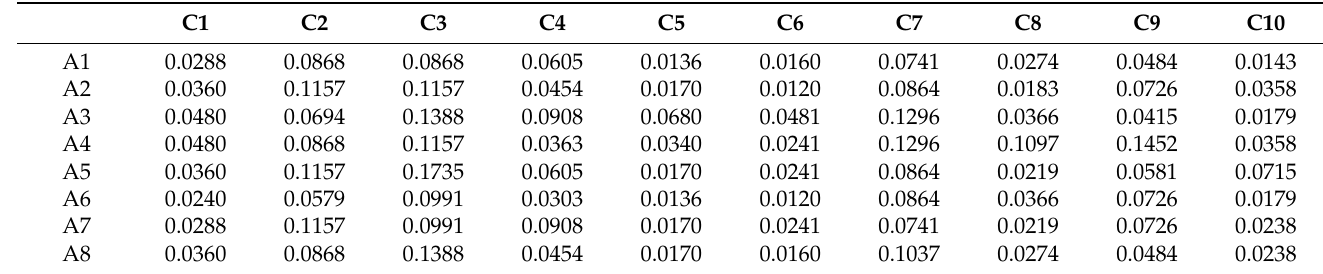
Table 4. Weighted normalization matrix for regulatory risk assessment of market-oriented business.